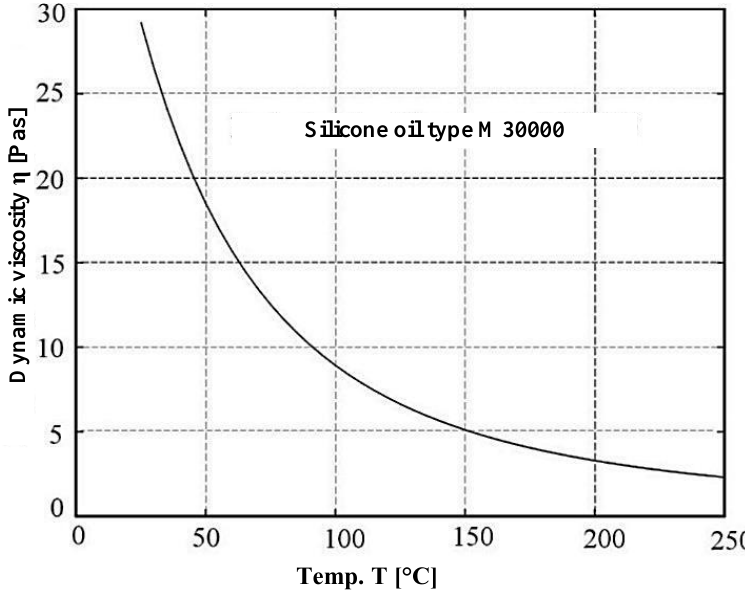
Figure 13. Dynamic viscosity of oil M30000 as a function of temperature.